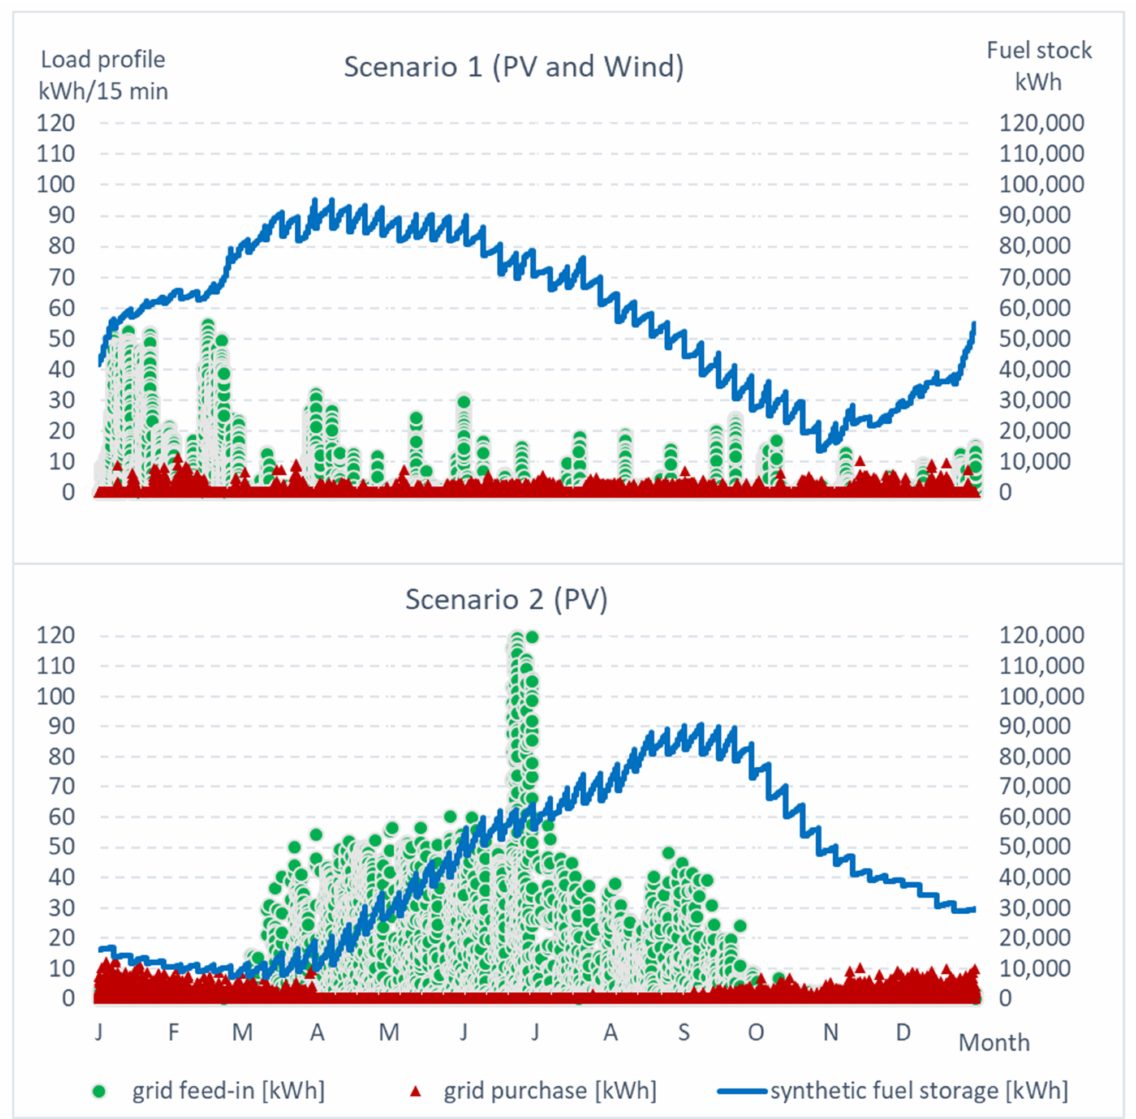
Figure 7. Load profile of grid feed-in and purchased electricity, as well as stocks of synthetic fuels for both scenarios (1 and 2) over the course of the